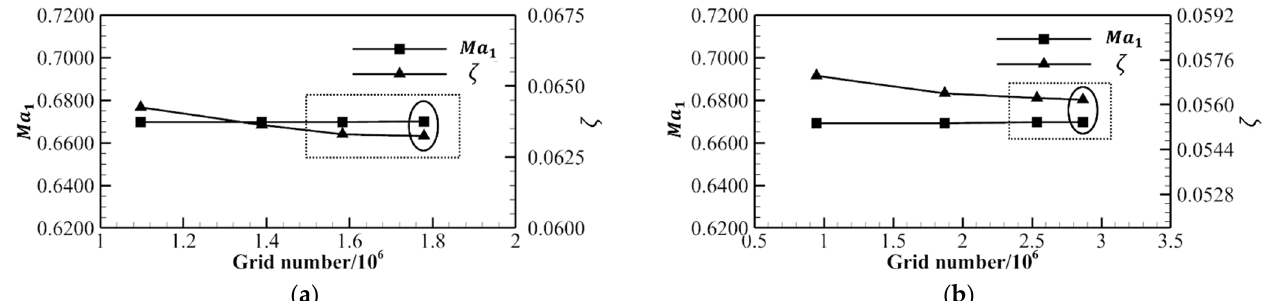
Figure 4. Grid independence validation at design condition: ( a ) Original cascade; ( b ) Tandem cascade.